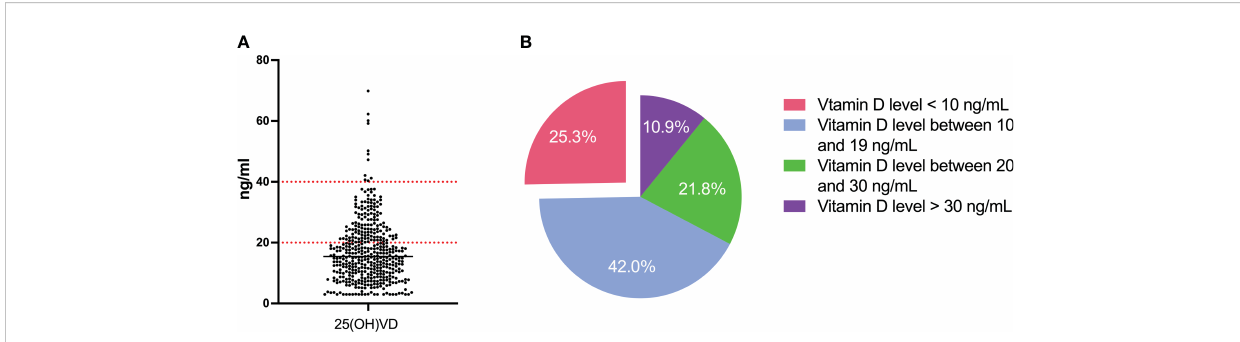
FIGURE 1 Level of vitamin D of NDMM patients. (A) The serum level of 25-OH-D3 of all patients; (B) Distribution of patients according to the serum level of